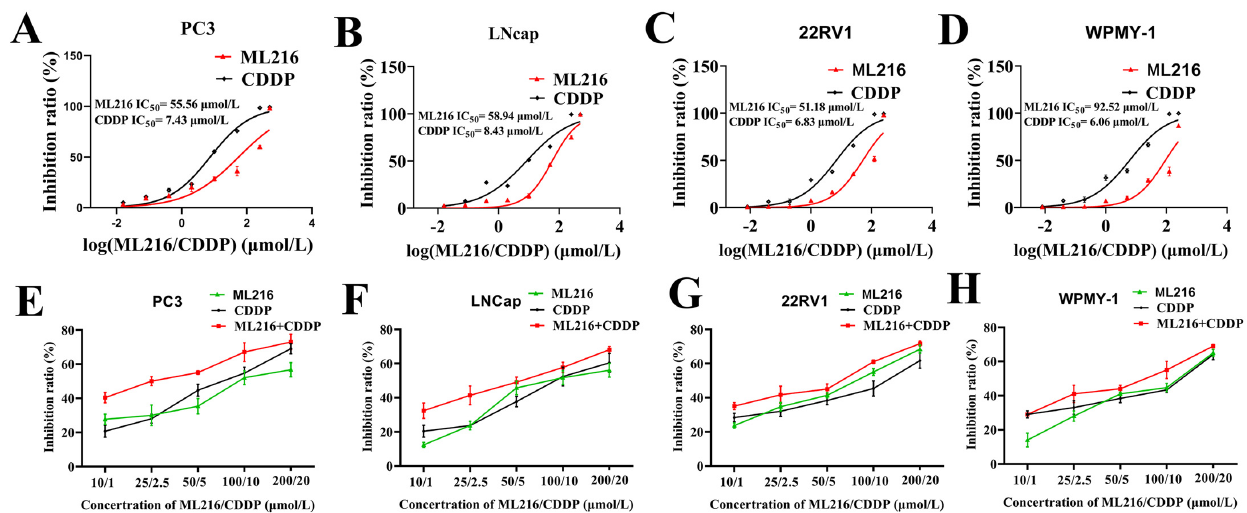
Figure 2. ML216 sensitizes CDDP-induced cytotoxicity in PCa cells. ( A – C ) Inhibition ratios in prostate cells following 48 h treatment: for PC3 cells, ML216 IC 50 − 55.56 µ mol/L and CDDP IC 50 − 7.43 µ mol/L ( A ); for LNcap cells, ML216 IC 50 − 58.94 µ mol/L and CDDP IC 50 − 8.43 µ mol/L ( B ); for 22RV1 cells, ML216 IC 50 − 51.18 µ mol/L and CDDP IC 50 − 6.83 µ mol/L ( C ); for WPMY-1 cells, ML216 IC 50 − 92.52 µ mol/L and CDDP IC 50 − 6.06 µ mol/L ( D ). ( E – H ) MTT assay was conducted in PC3, LNCap, 22RV1 and WPMY-1 cells treated with CDDP and ML216 for 48 h. Inhibition ratio curves were shown, respectively.